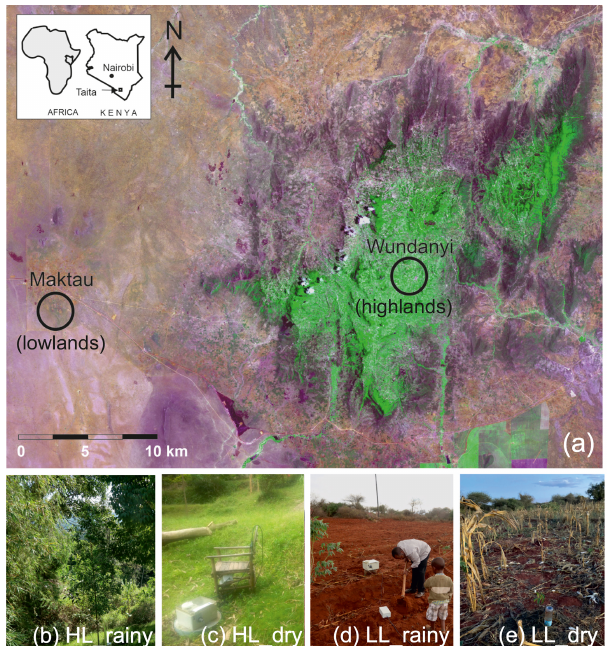
Figure 2. Locations of the highland site (HL) in Wundanyi and the lowland site (LL) in Maktau. The green color in the true color Sen- tinel satellite image (a) shows the forests and agricultural area in the Taita Hills, while magenta represents grassland with a few fire scars. The brownish areas are areas with less land cover, such as dry bush- land, dryland agriculture, and areas used for livestock management. Photographs in panels (b, c, d, e) show the phenological conditions and the surrounding environments of the measurement sites during sampling in the rainy season in April and dry season in September. Photographs by Simon Schallhart, Finnish Meteorological Institute, and Petri Pellikka, University of